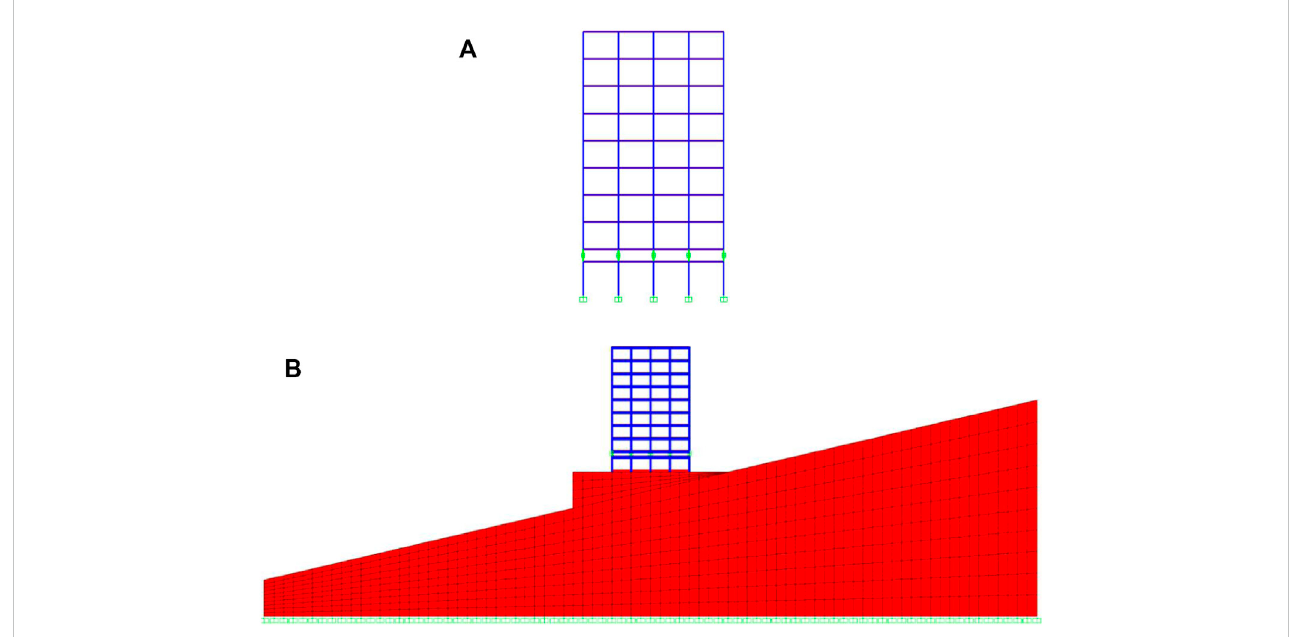
FIGURE 1 Model elevation. (A) Vertical plane of the mid-story-isolated structure. (B) Vertical plane of the mid-story-isolated structure considering the soil – structure interaction (SSI) in sloping